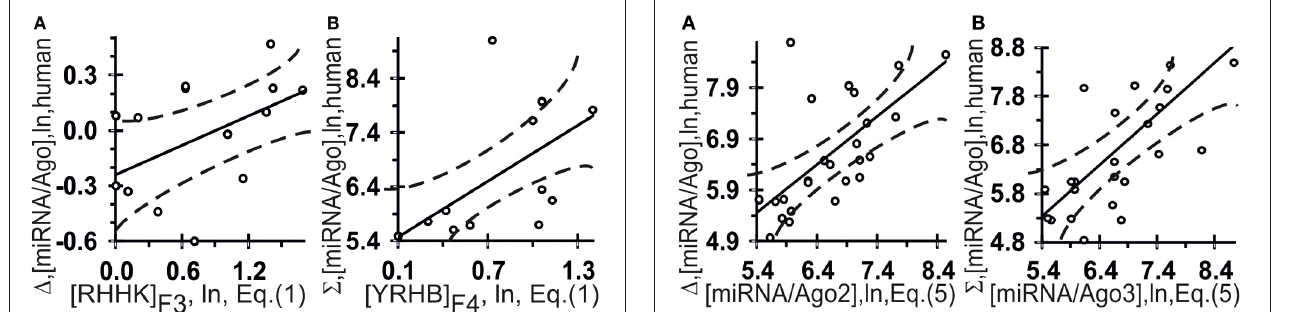
FIGURE 5 | Control test of the patterns (the x -axis) found by ACTIVITY (Ponomarenko et al., 1997) in the training dataset (Table 2) using independent experimental data (the y -axis) taken from same data source (Azuma-Mukai et al., 2008). Two statistically significant linear correlations: one (A) between the miRNA/Ago-affinity estimate ( (cid:4) ) and [RHHK] F3 ; and one (B) between another estimate ( (cid:3) ) and [YRHB] F4 . Both are statistically significant in the control dataset of 16 canonical miRNAs